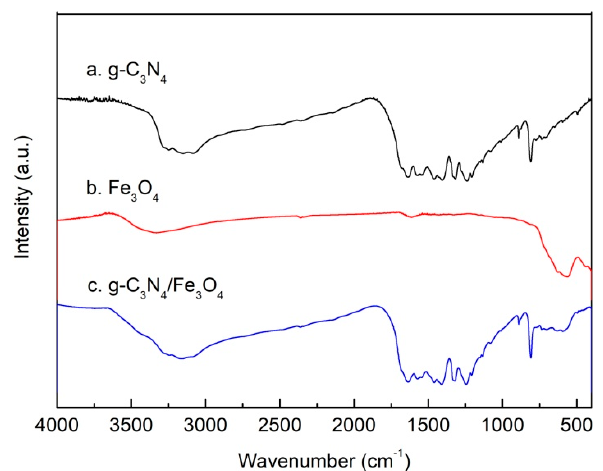
Figure 4. IR spectrum of g-C 3 N 4 ( a ), Fe 3 O 4 ( b ), and g-C 3 N 4 / Fe 3 O 4 ( c ).